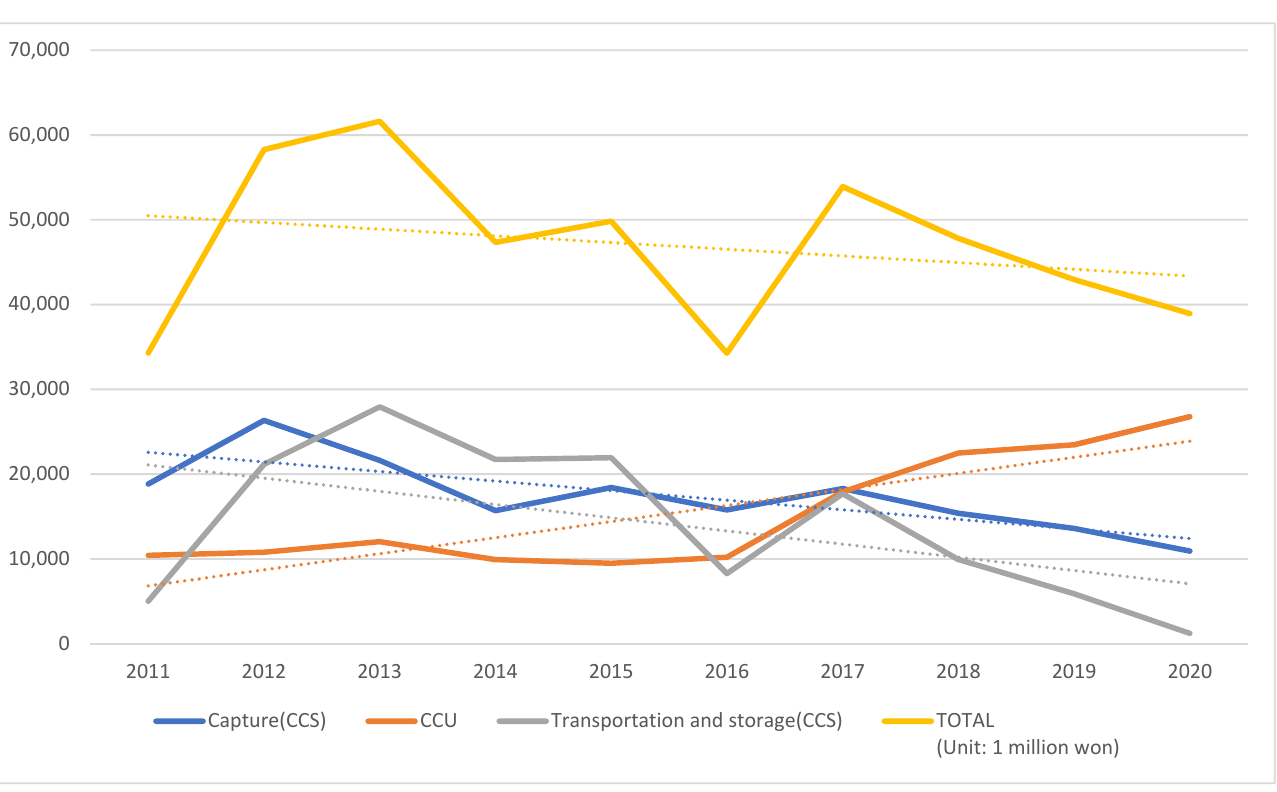
Figure 6. R&D investment in CCUS over the past ten years from 2011 to 2020 (data from MSIT, 2021). Table 2 shows the result of the correlation between R&D investment in CCUS and capture, utilization, and transportation/storage. The capture ( p ≤ 0.05) and transporta- tion/storage ( p ≤ 0.01) have significant correlations with volatility in CCUS investments. Table 2. The result of the correlation between R&D investment in CCUS. Capture Utilization Transportation/Storage Total Pearson correlation 0.653 * − 0.162 0.849 ** 10 *. Correlation significant at 0.05-level (both sides), **. Correlation significant at 0.01-level (both sides).